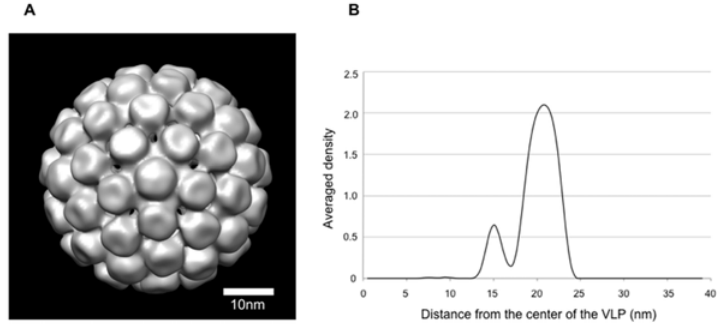
Fig 3. Cryo-EM. (A) A reconstructed 3D image of the MCPyV-LP. UCSF Chimera was used to visualize this structure [38]. The threshold for isosurface representation was calculated such that the volume could include 100% of the mass of the MCPyV-LP. Bar, 10 nm. (B) One-dimensional profile demonstrating the rotationally averaged density of the reconstructed volume. Density is plotted against distance from the center of the virus particle. Values outside the particle dimensions were masked out.